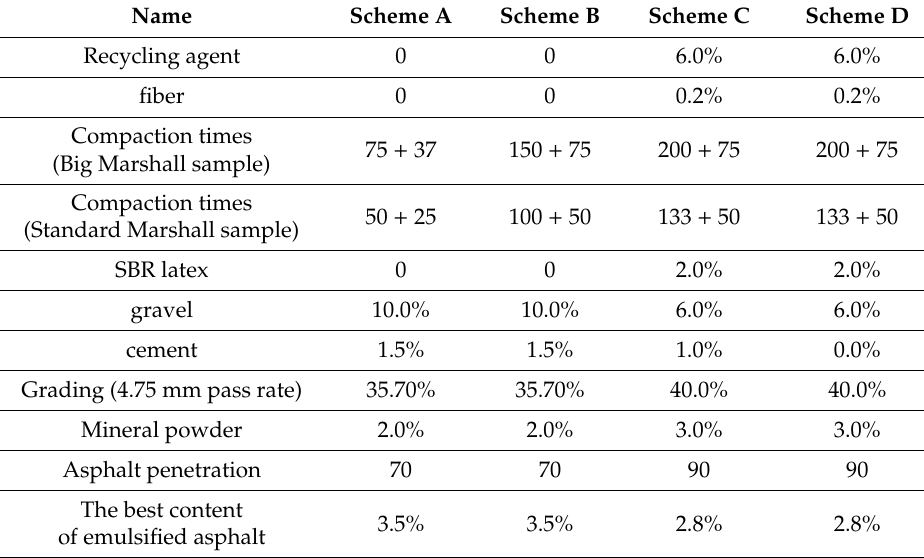
Table 6. Four types of mixture